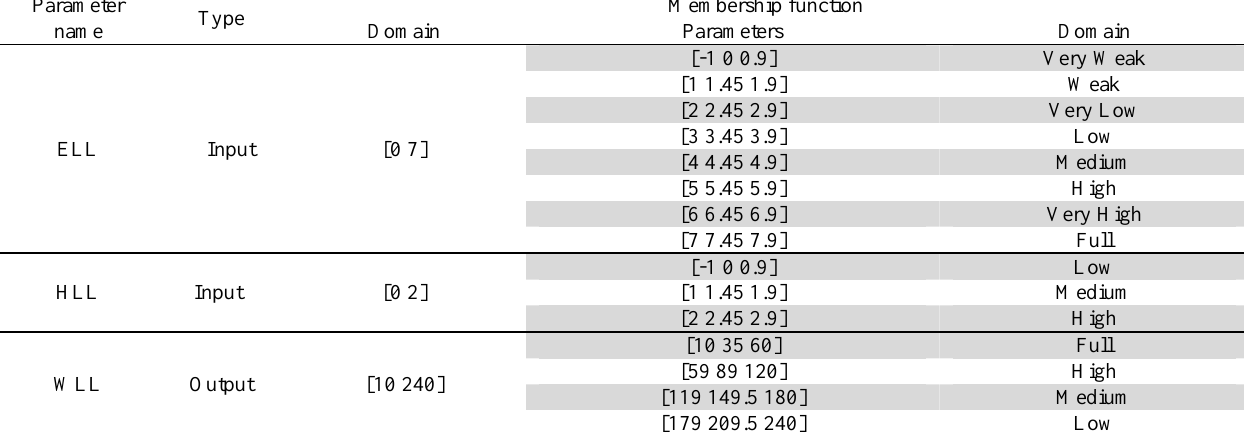
Fuzzy Inference System parameters for determining the value weight per